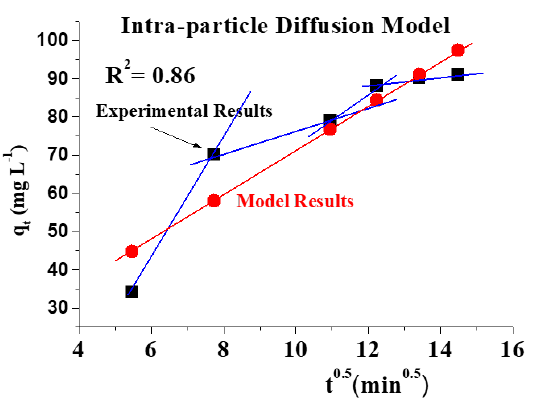
Figure 10. Diffusion figure for adsorption of Na + intraparticle with an initial concentration of 10,000 mg/L at 27 °C, pH = 4 over 500 min.